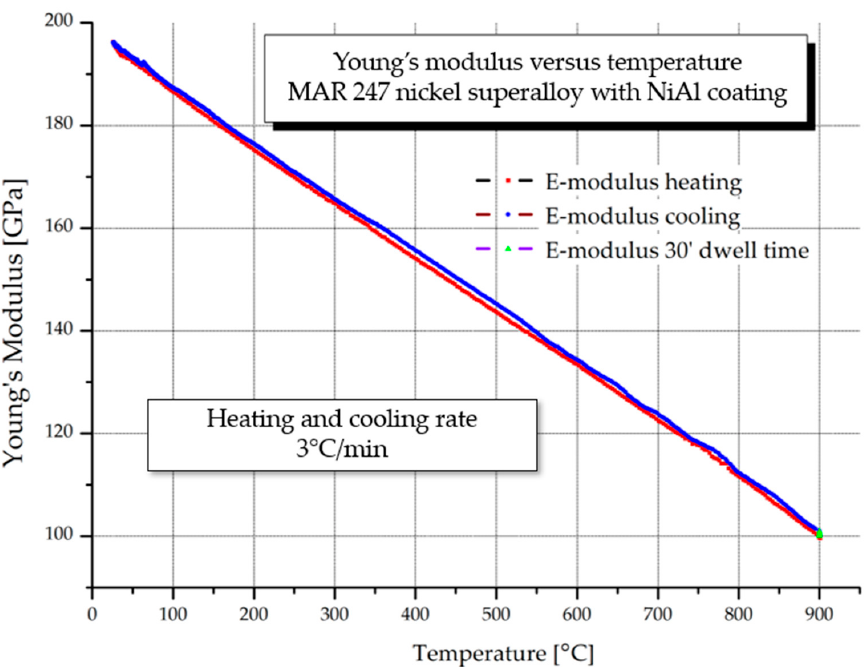
Figure 8. Evolution of the Young’s modulus of coated MAR 247 nickel based superalloy at the temperature of 22–900 ◦ C, during annealing and cooling at a rate of 3 ◦ C / min to 900 ◦ C.